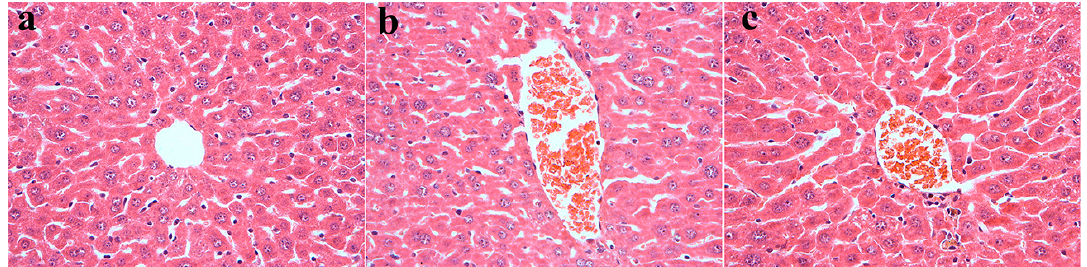
Figure 2. Histopathological analysis of EPE3k on hepatic tissues in the normal ( a ), model ( b ), and EPE3k ( c ) groups with hematoxylin and eosin staining at 400× magnification.